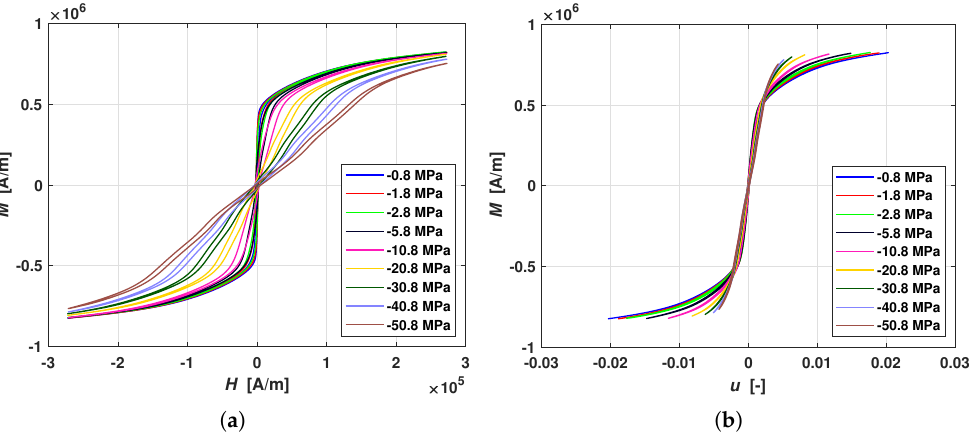
Figure 9. Magnetic characteristics ( M - H ) at different applied compressive stresses σ ( a ) and graphical representation of the self-similarity property ( b ) for Terfenol-D. It is possible to note how the M - u curves almost collapse into a single one, where u is defined as in Equation (20) with the parameters obtained from the minimization computation.